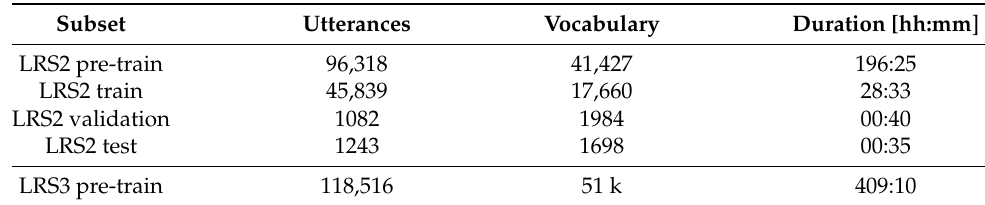
Table 2. Characteristics of the utilized